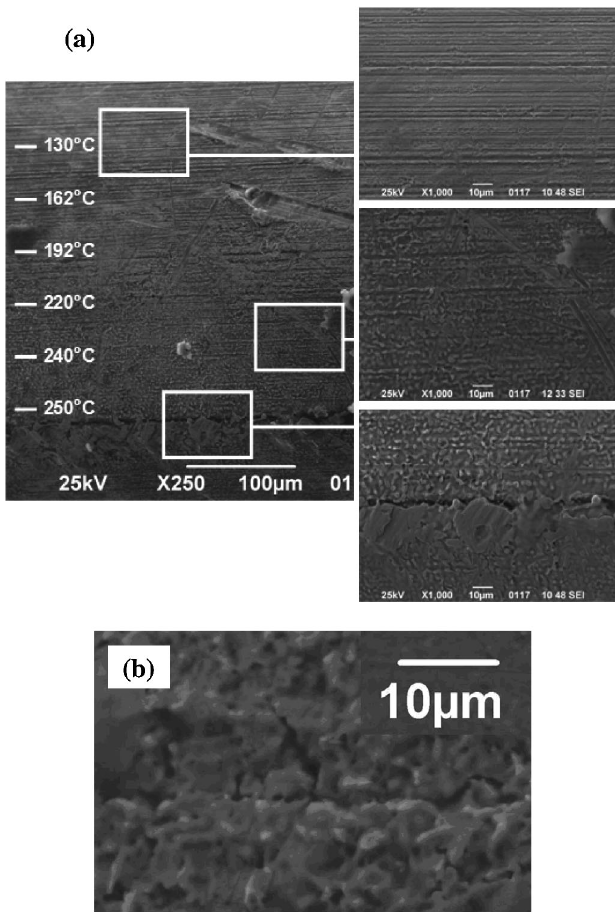
FIG. 9. (a) Photographs (electron microscope) of the central part of the waistband after irradiation by 6 (cid:2) 10 4 pulses with magnification of 250 (left) and 1000 (right). (b) Central part of the waistband (different piece having temperature rise of (cid:4) 250 (cid:1) C ) with magnification of